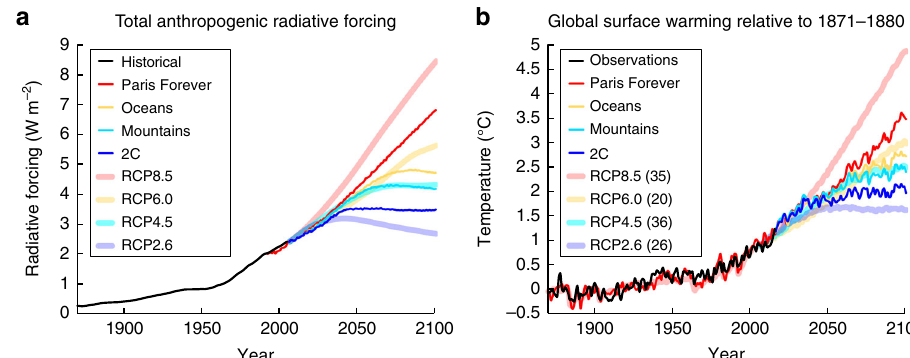
Fig. 2 Radiative forcing and global temperature change. Time series of a total anthropogenic radiative forcing (W m − 2 ) and b global surface warming (°C) relative to 1871 – 1880 for the Paris Forever, Oceans, Mountains and 2C integrated economic and climate scenarios along with the 4 RCP scenarios. The multi-model ensemble mean is shown for global mean temperature in the 4 RCPs. Numbers in parentheses represent the number of climate models in the ensemble under each RCP scenario. Temperature observations are from the Berkeley Earth Surface Temperatures (BEST 92